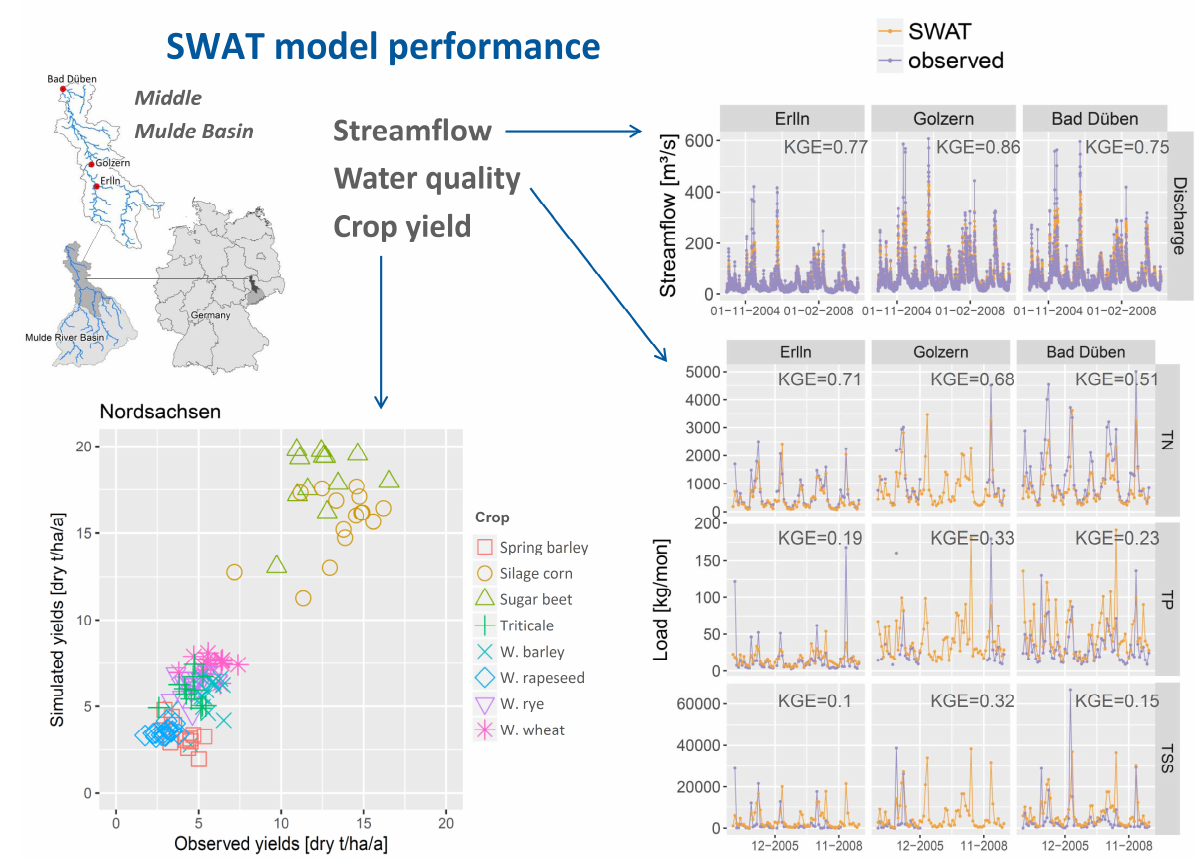
Figure A1.1: SWAT model performance for predicting daily streamflow, monthly water quality and mean annual crop yields the Middle Mulde